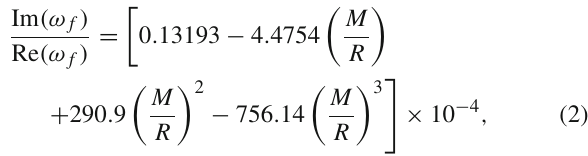
empirical relation for Im (ω) /Re (ω) (cid:2) 10 − 5 , i.e., except for